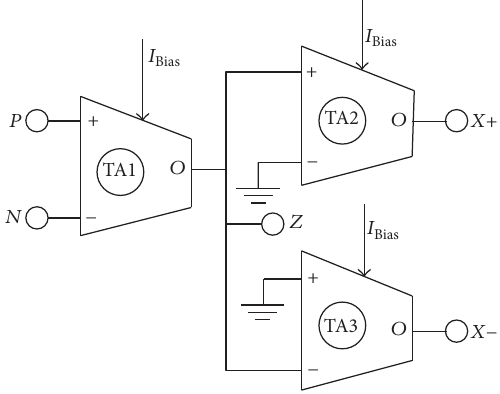
Figure 15: VDTA implantation using OTA.